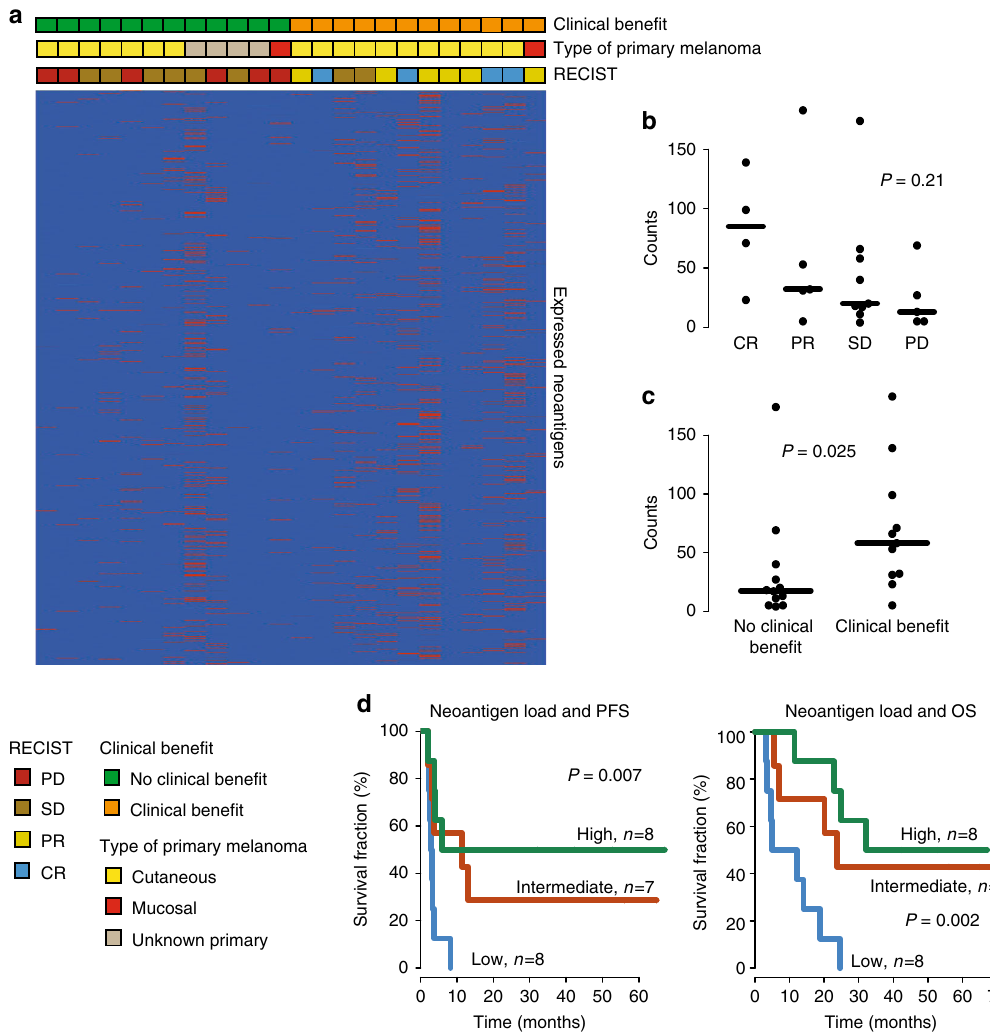
Fig. 5 Neoantigen load is associated with bene fi t from ACT in melanoma. a Expressed predicted neoantigens are depicted in patients with and without clinical bene fi t from ACT. b , c The number of expressed predicted neoantigens by RECIST response b and clinical bene fi t status c . P -value from Kruskal – Wallis and Mann – Whitney tests, respectively. Solid black line indicates the median. d Expressed predicted neoantigen load is signi fi cantly associated with progression-free (PFS) and overall survival (OS). P -value from Cox regression. RECIST categories: CR complete response, PD